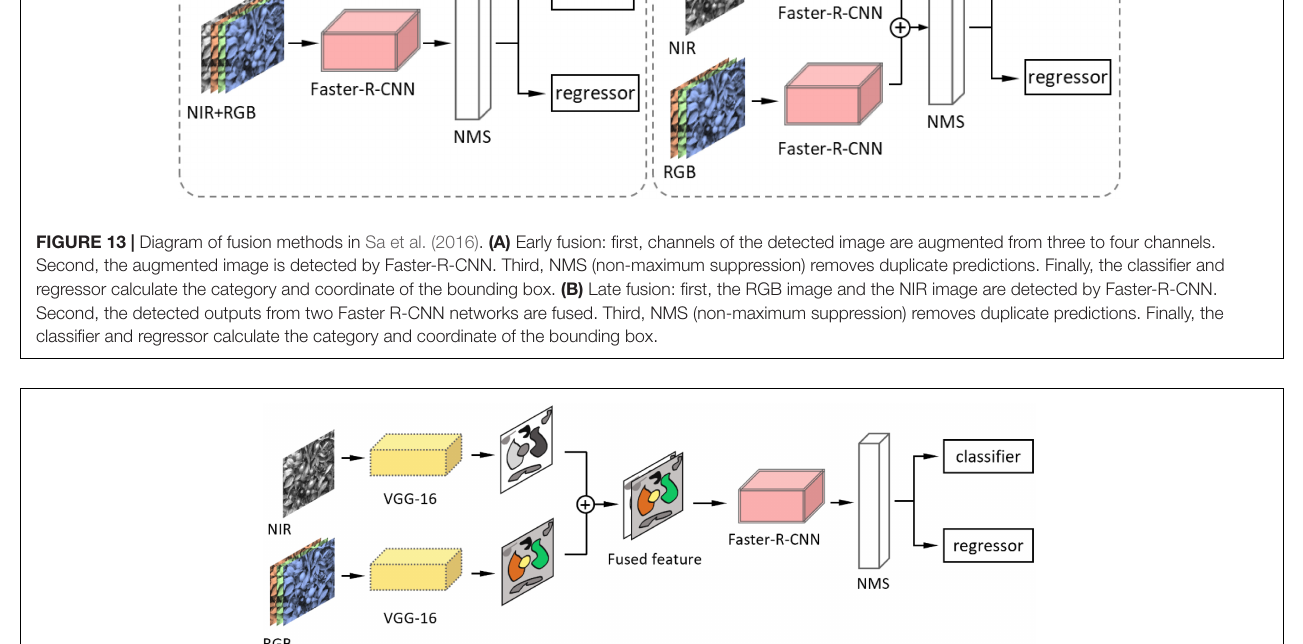
FIGURE 14 | Feature-fusion model in Liu et al. (2019). First, it inputs the RGB and NIR images separately into two VGG16 networks and then combined them on the feature map; then, the feature map is detected by